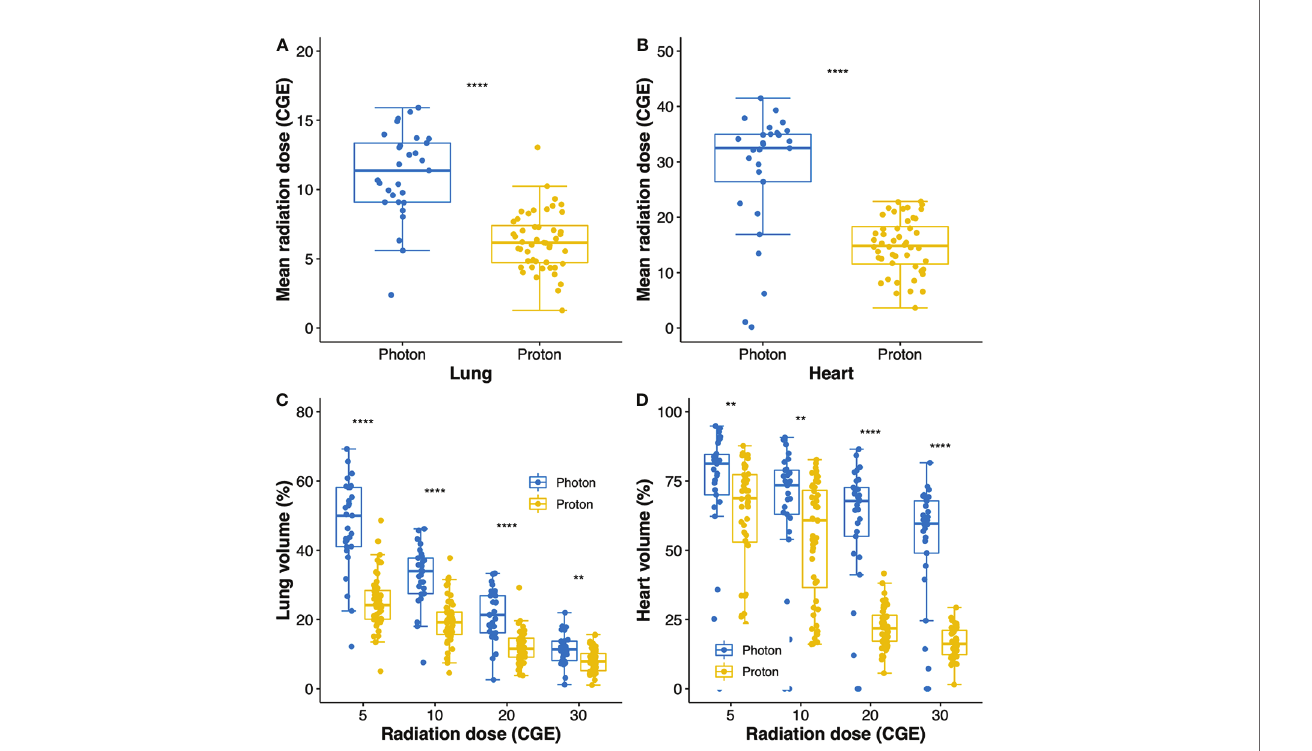
FIGURE 1 | Box plots of mean radiation doses to the lung (A) and heart (B) . Box plots showing the distributions of dose – volume indices for the lung (C) and heart (D) . Whiskers indicate 1.5 times the interquartile range above and below the mean; dots represent individual observations. CGE, cobalt gray equivalent. ** p < 0.01, **** p <